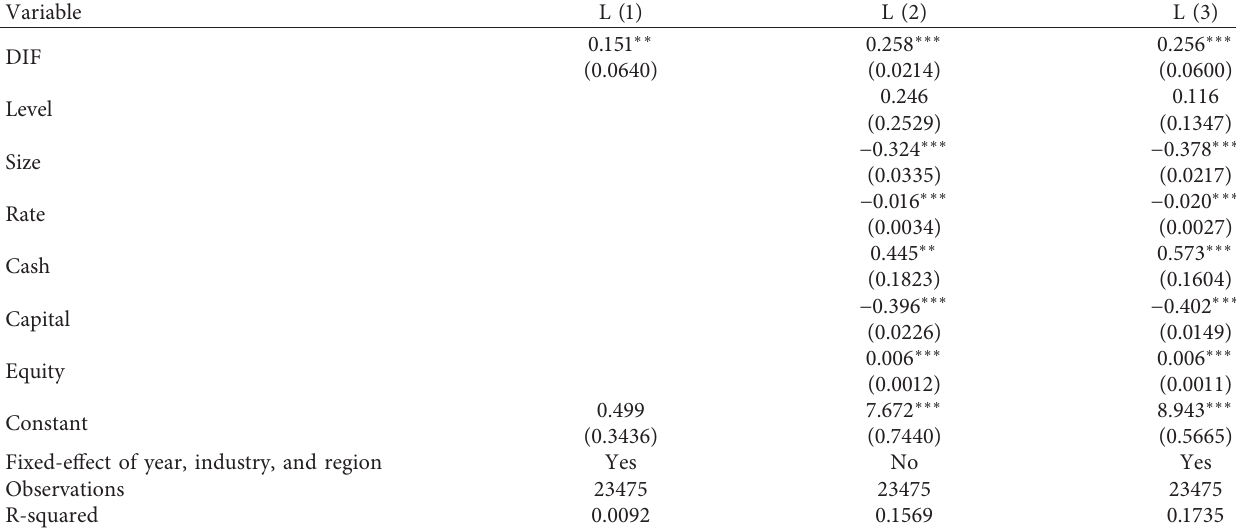
Table 3: The baseline regression results between digital finance and enterprise financial risk.